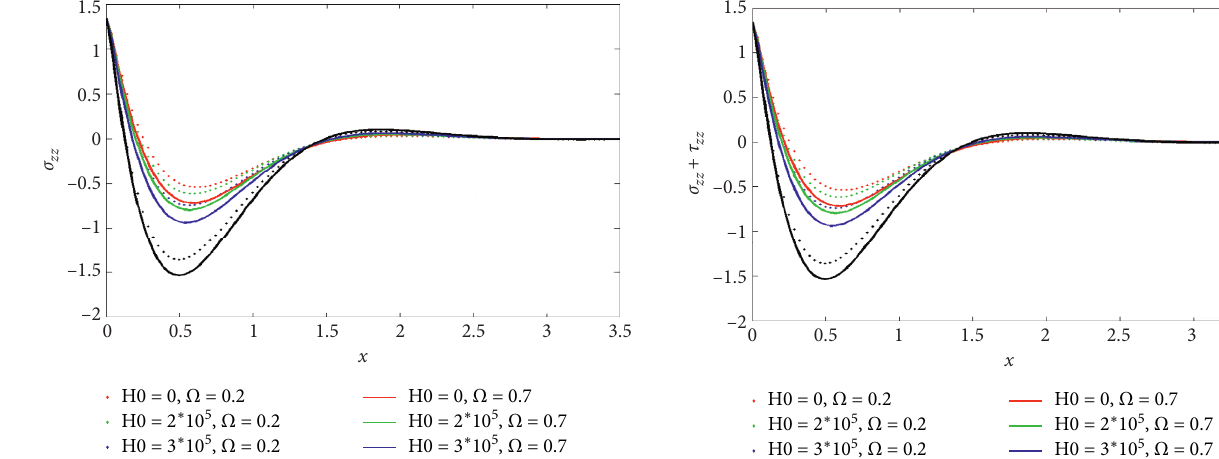
+ σ zz zz concerning